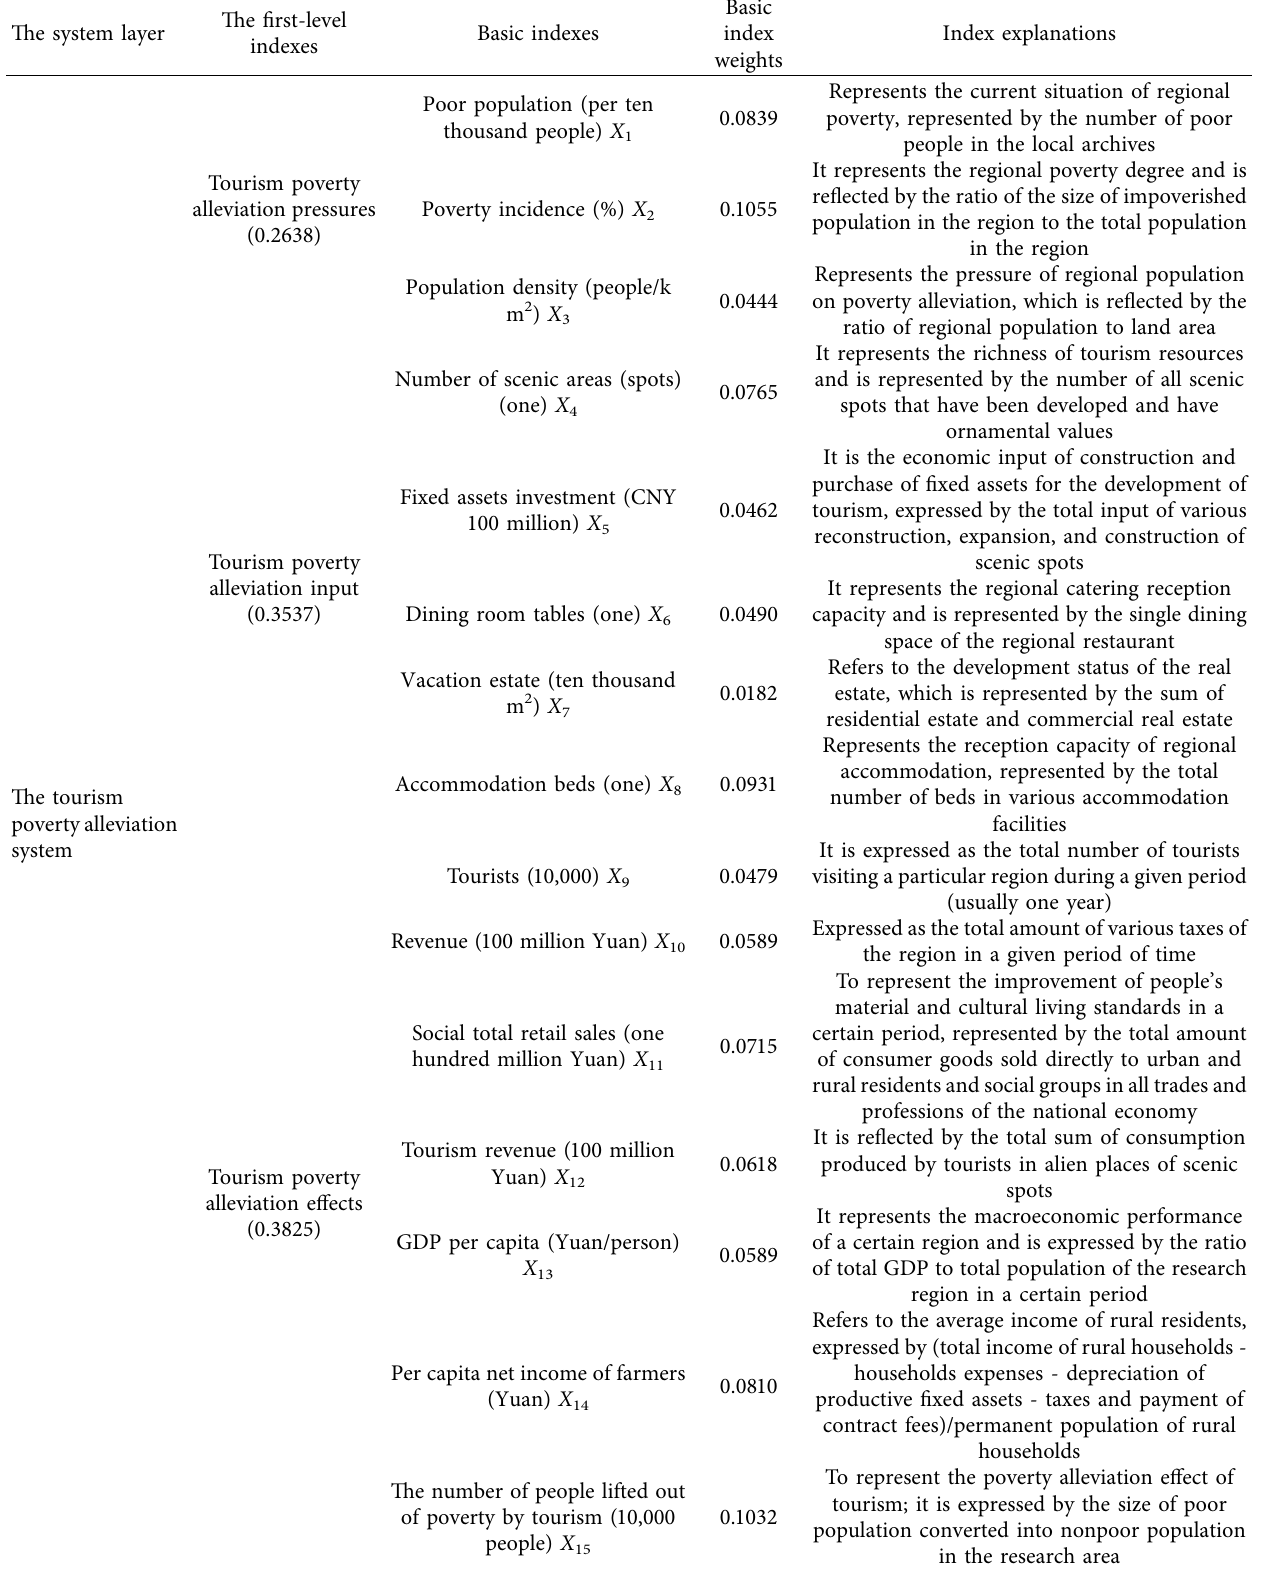
Table 1: The pro-poor tourism system assessment indexes and meanings in poor mountainous